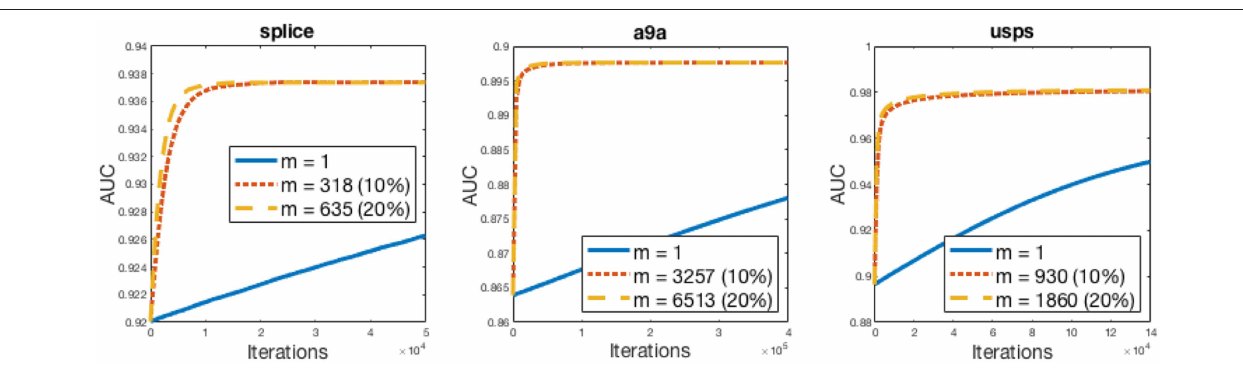
regSOLAM both achieve similar performances as other state-of- the-art online and offline methods based on AUC